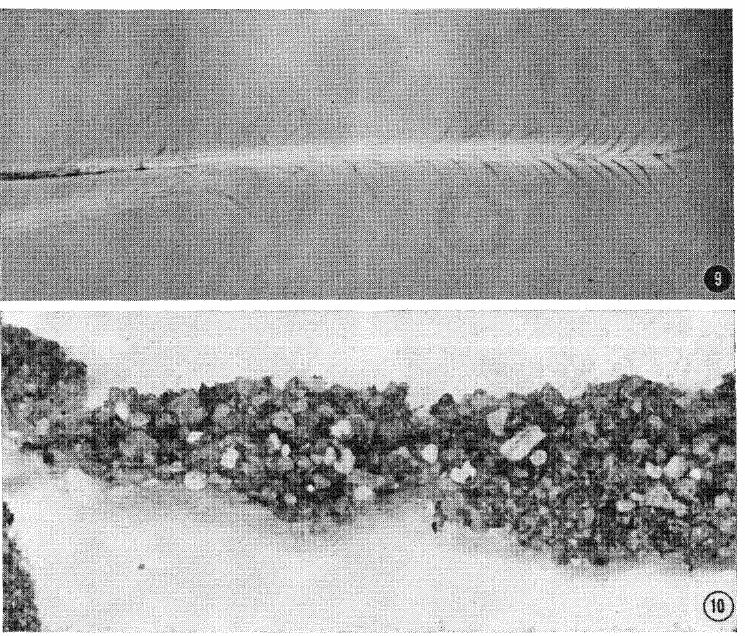
Fig. 9. A seta removed showing the branches to which dust particles cling. The seta is about mm long; the section shown is about 0.5 mm long, photographed with phase microscopy. Fig. 10. A portion of the basal disc of the eggcase. Only very few threads are used to hold the sand